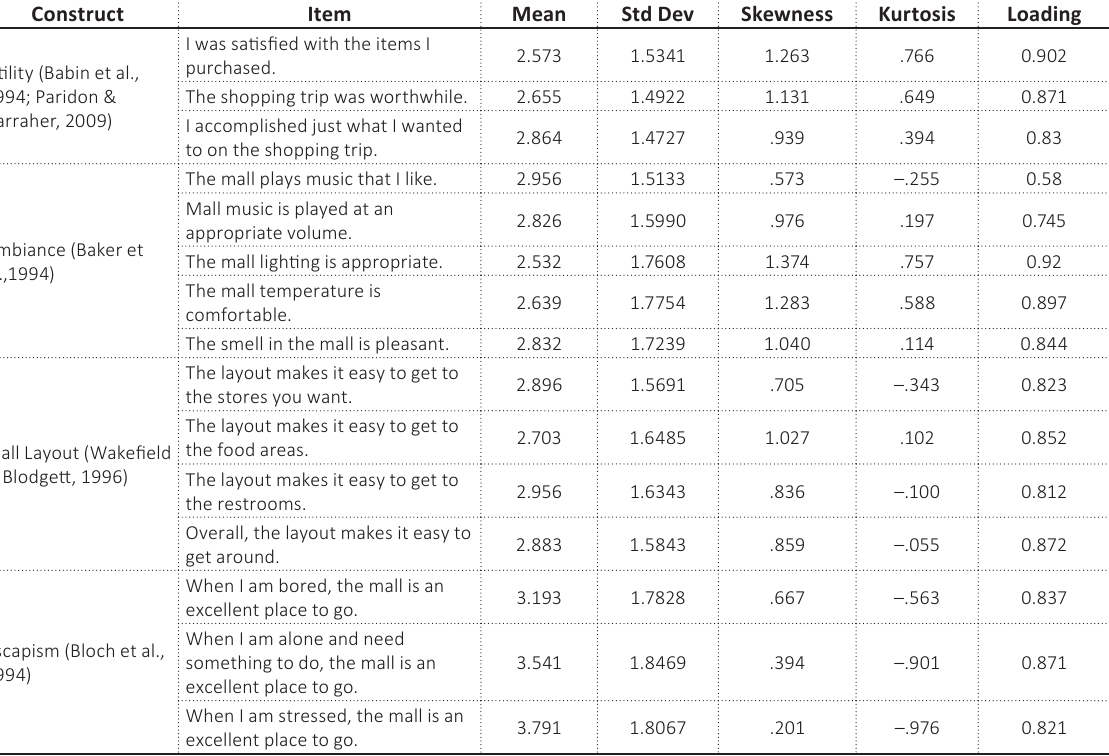
Table 2. Statistical data